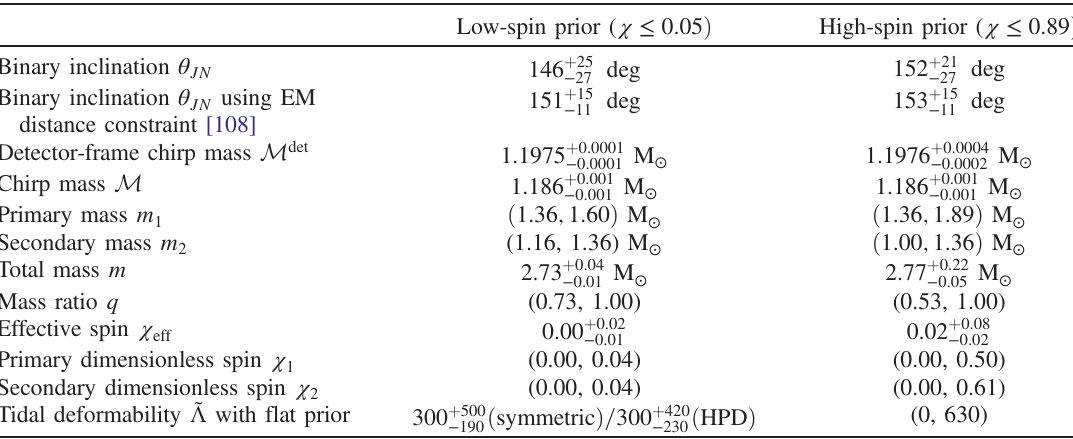
TABLE II. Properties for GW170817 inferred using the PhenomPNRTwaveform model. All properties are source properties except for the detector-frame chirp mass M det ¼ M ð 1 þ z Þ . Errors quoted as x þ z − y represent the median, 5% lower limit, and 95% upper limit. Errors quoted as ð x; y Þ are one-sided 90% lower or upper limits, and they are used when one side is bounded by a prior. For the masses, m 1 is bounded from below and m 2 is bounded from above ˜ Λ by the equal-mass line. The mass ratio is bounded by q ≤ 1 . For the tidal parameter , we quote results using a ˜ Λ ˜ Λ constant (flat) prior in . In the high-spin case, we quote a 90% upper limit for , while in the low-spin case, we report both the symmetric 90% credible interval and the 90% highest posterior density (HPD) interval, which is the smallest interval that contains 90% of the